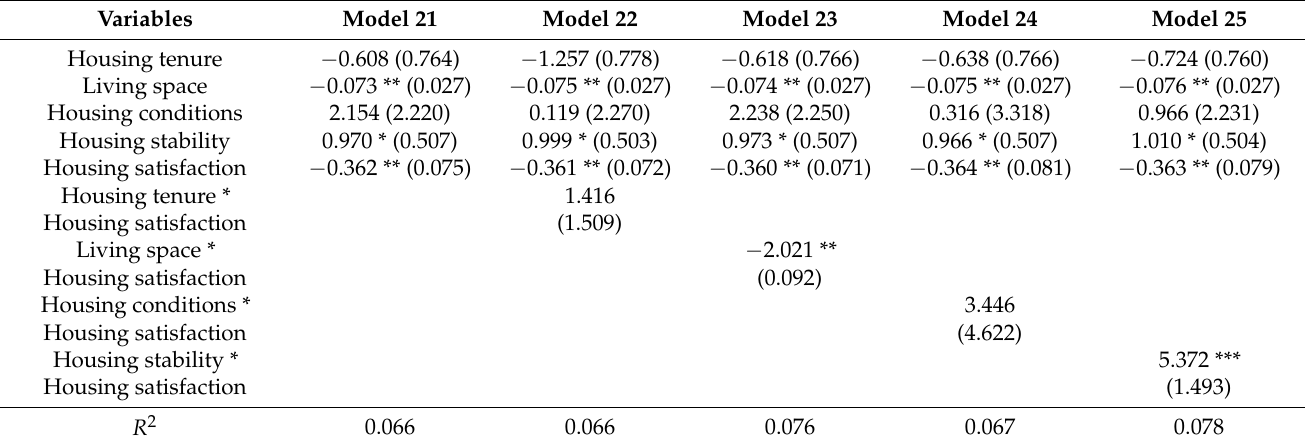
Table 7. The moderating effects of subjective housing status on the relationship between objective housing status and